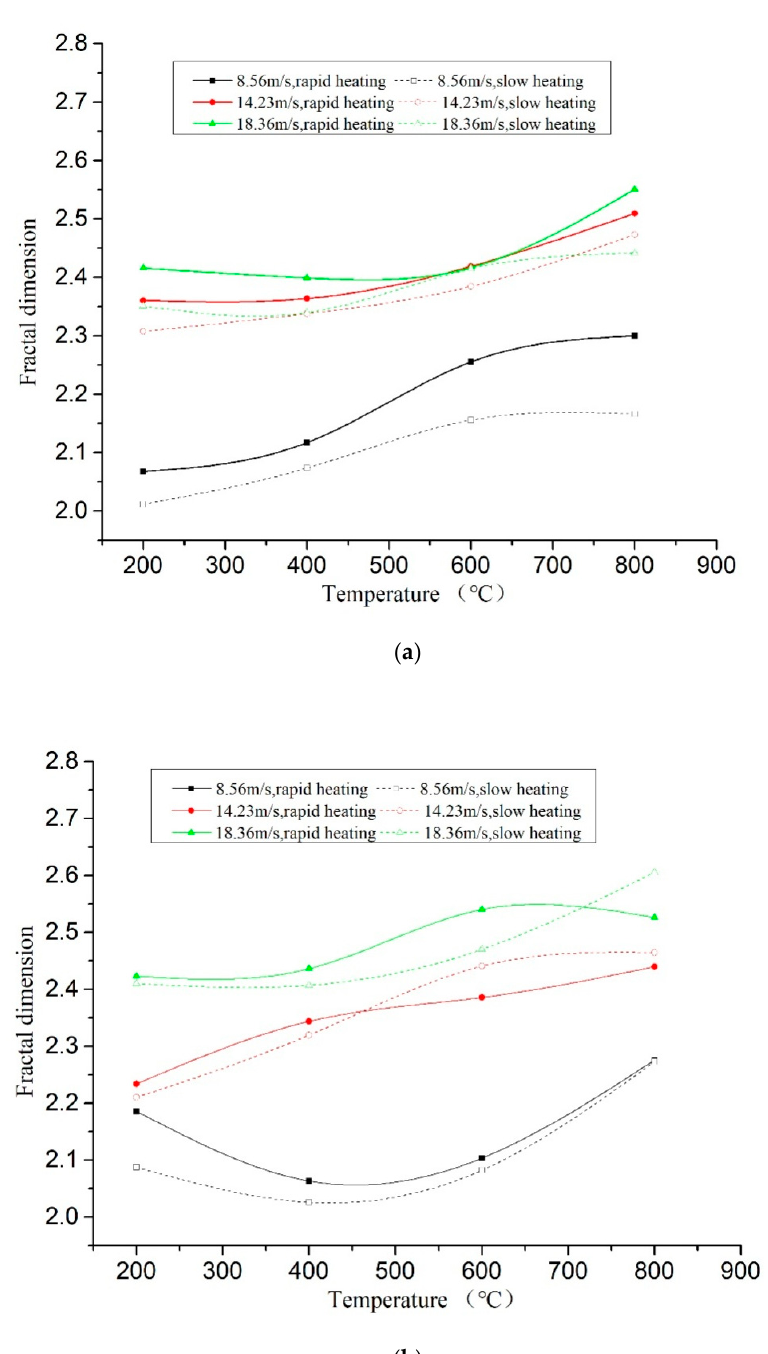
Figure 12. Comparison of the fractal dimensions under different temperature gradients. ( a ) Comparison of specimens under different heating methods, water cooling; ( b ) Comparison of specimens under different heating methods, natural cooling.